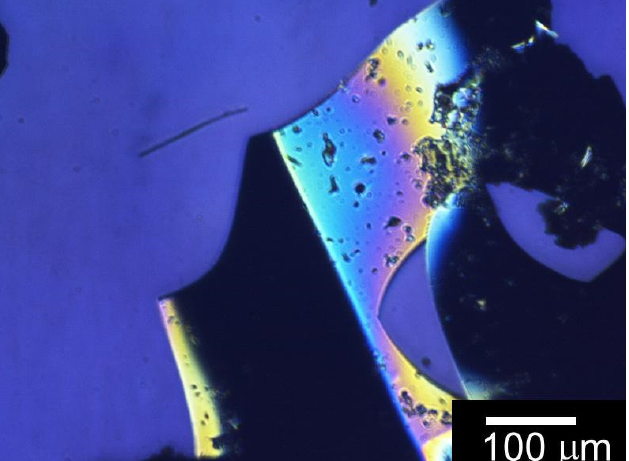
Figure 3. Optical microscopy image of a carbonized material from PANI-(+)-CSA, abbreviated as V-CB(PANI).